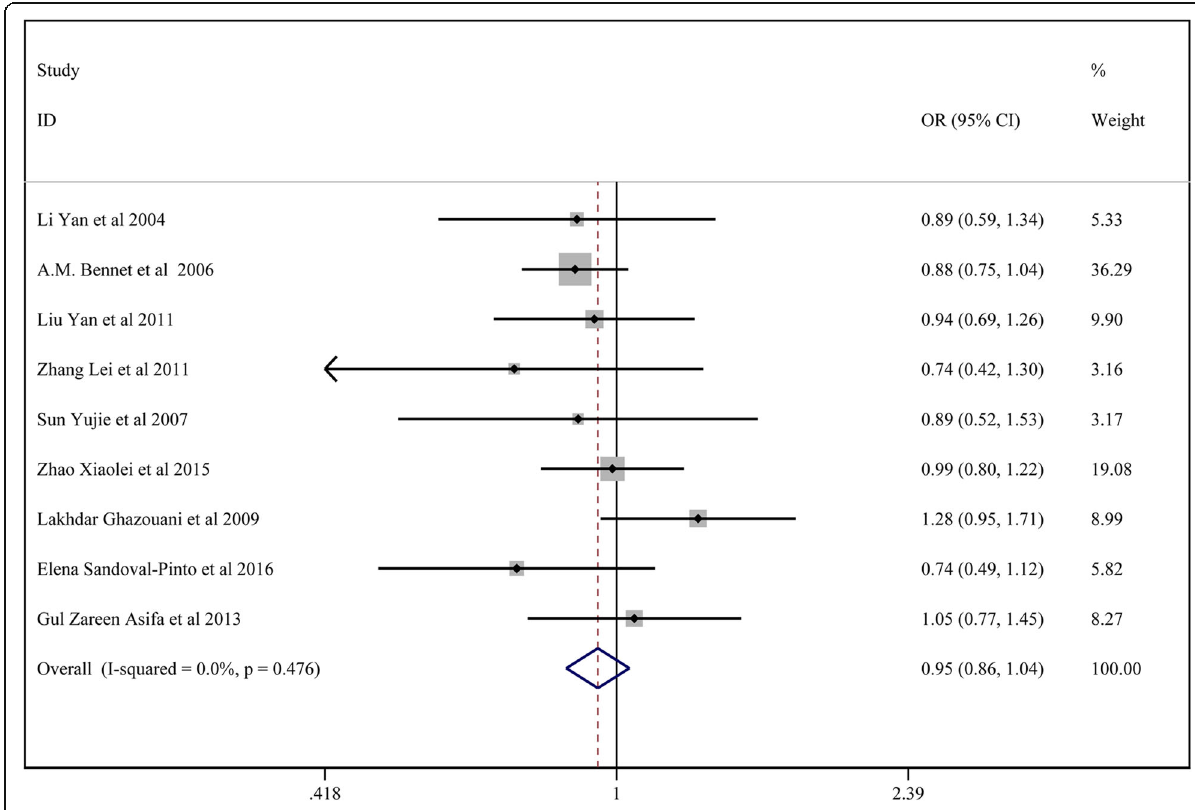
Fig. 8 Forest plot for the dominant model of TNF- α 1031 T/C polymorphisms associated with CAD